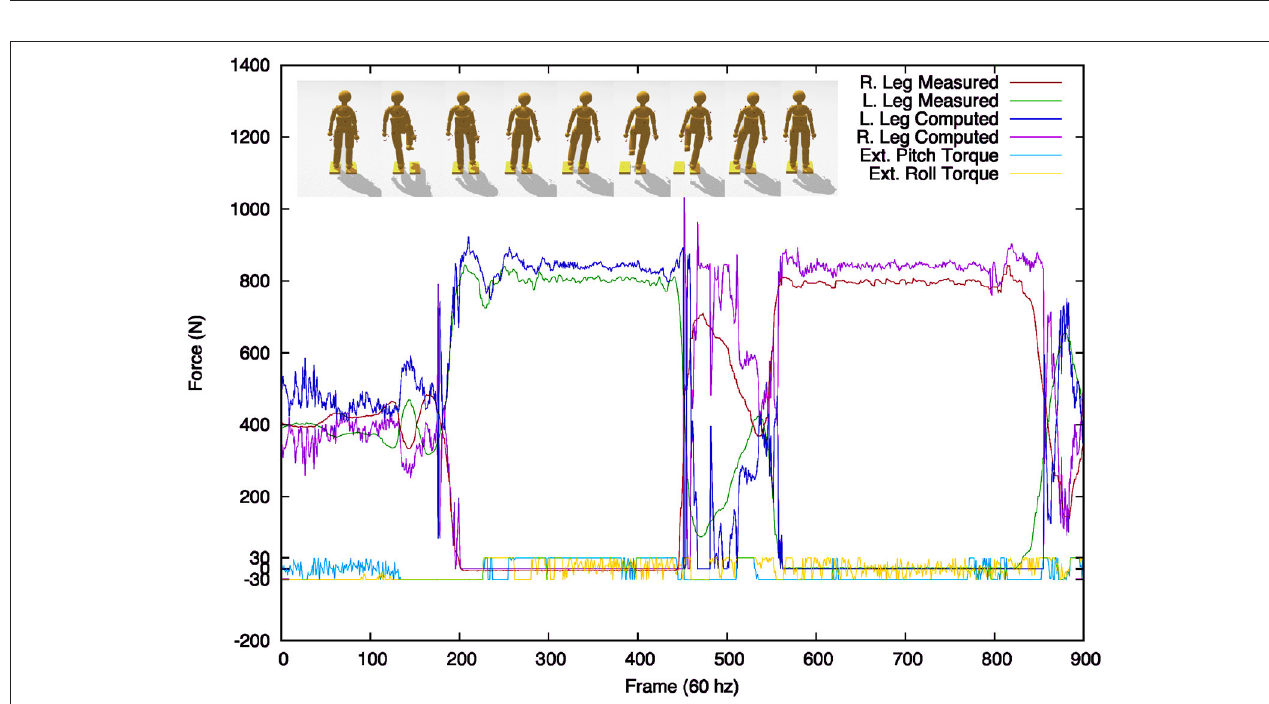
FIGURE 8 | Comparing ground forces between the model and the Wii force plate. (Top) Two Wii force plates serve as accurate calibration reference. A subject stood on the two plates and then changed stances, balancing first on the left foot and next on the right. (Bottom) The comparison between the measurement systems is surprisingly good, during the stance phases. The 10% difference between the Wii measured ground forces and the computed forces can be reconciled by including the model’s residual balance